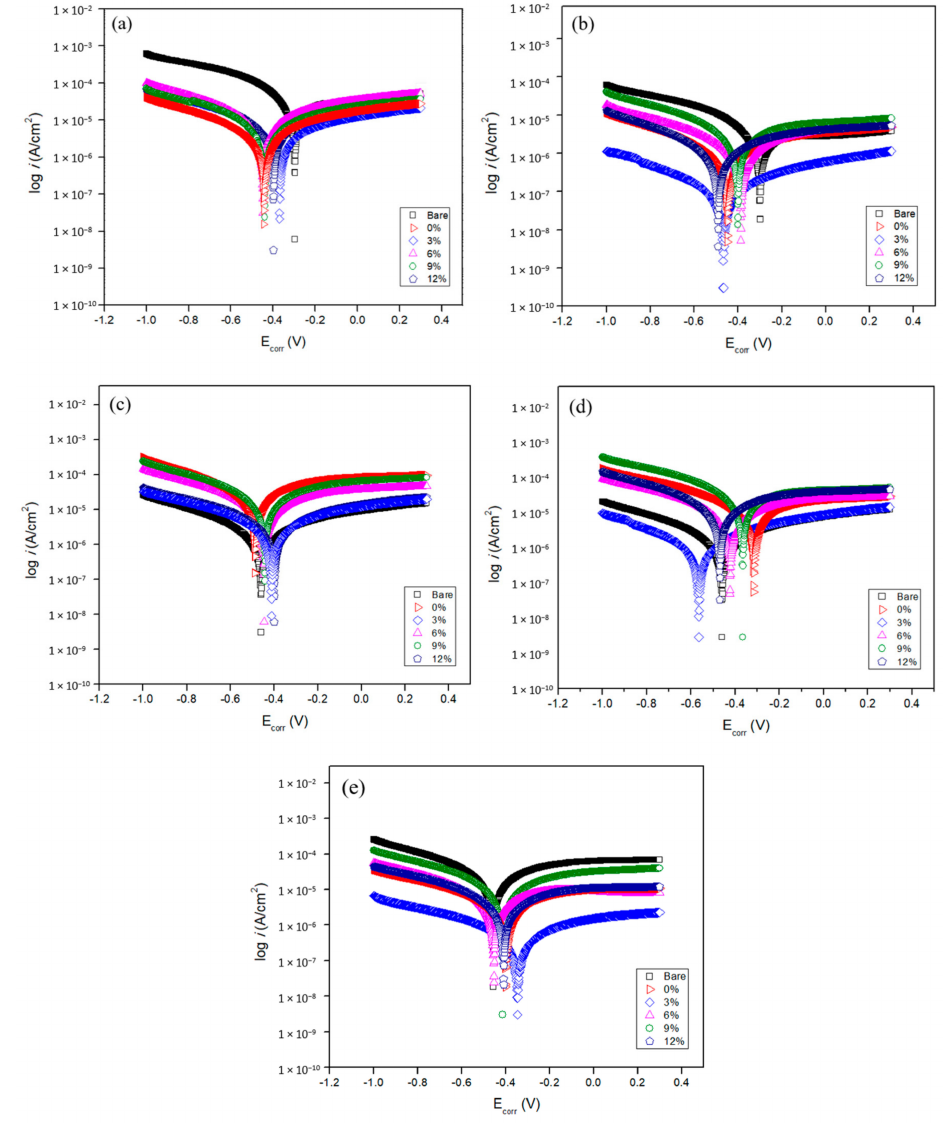
Figure 15. Tafel plots of the coated and the uncoated SS316L at ( a ) 10, ( b ) 20, ( c ) 30, ( d ) 40 and ( e ) 50 days of the immersion test at Setiu, Terengganu,